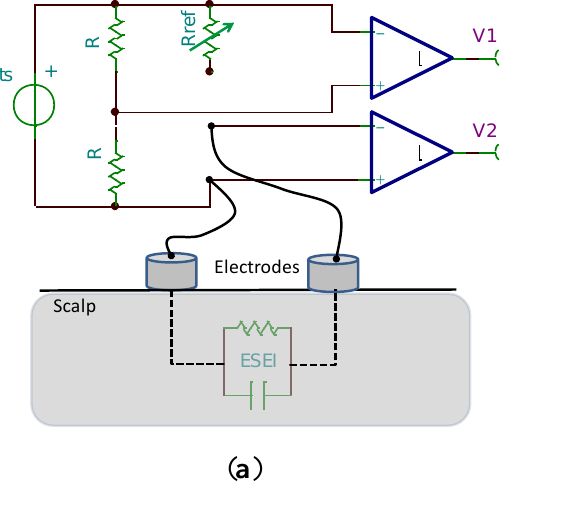
Figure 6. ( a ) Measure of ESEI by means of test signal. Adapted from [30]; ( b ) Impedance-to- voltage converter to measure the EEI. Adapted from [12]. Playback